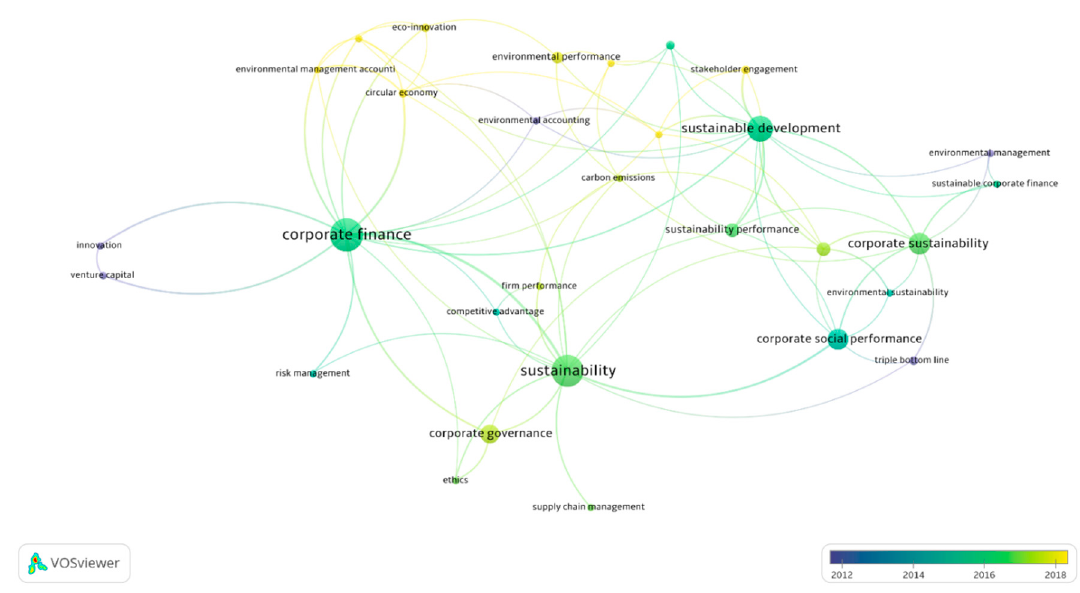
Figure 2. Co-occurrence of author keywords by publication year.